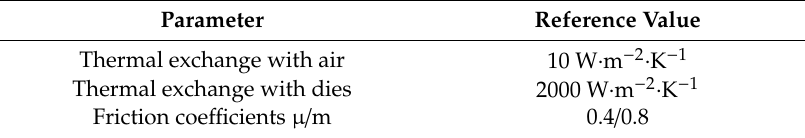
Table 6. Reference parameters of the FEM modelling of the representative test.